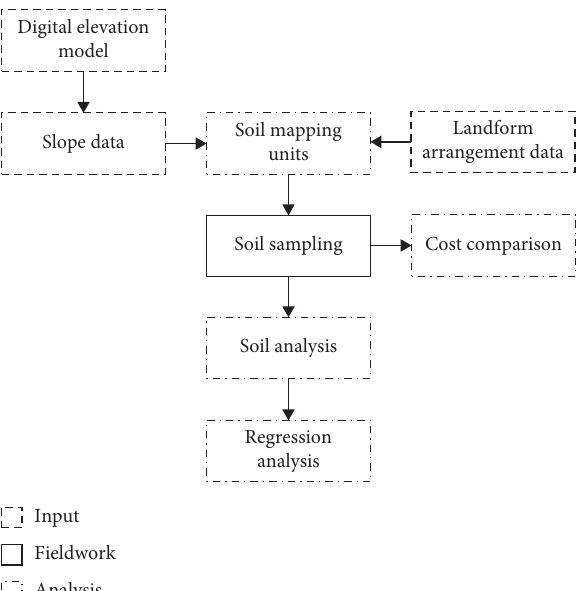
Figure 2: The flow of the research is divided into three parts: (1) data input, (2) fieldwork, and (3) Geomorphometric parameters are used to determine the boundary of a mapping unit. The area within a mapping unit